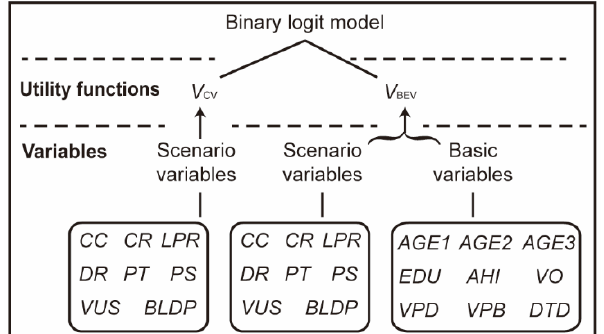
Figure 3. Variables contained in the utility functions of CVs and BEVs in the binary logit (BL) model.